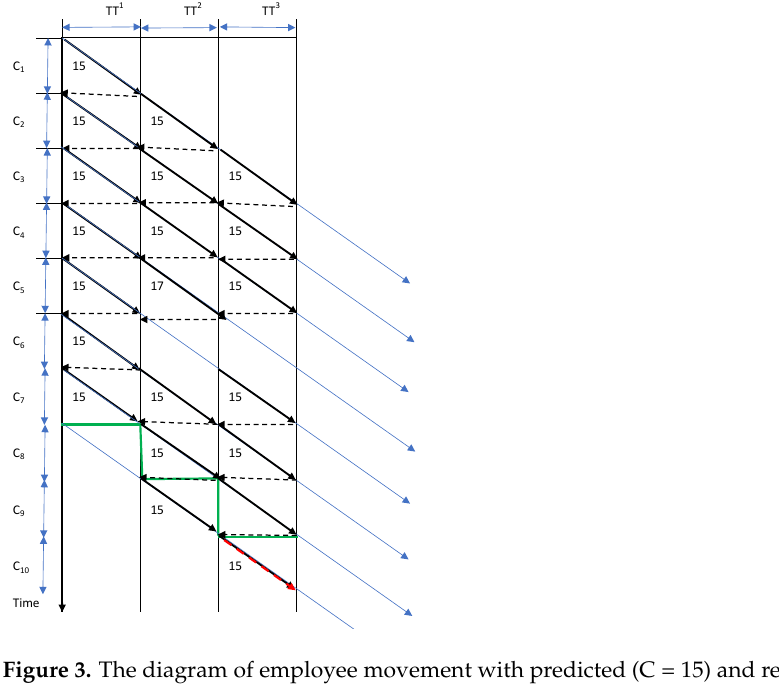
Figure 3. The diagram of employee movement with predicted (C = 15) and real disassembly cycle times (15, 17), transport cycle time (TT = 15) and when the product disassembly and/or transport operations are automated.